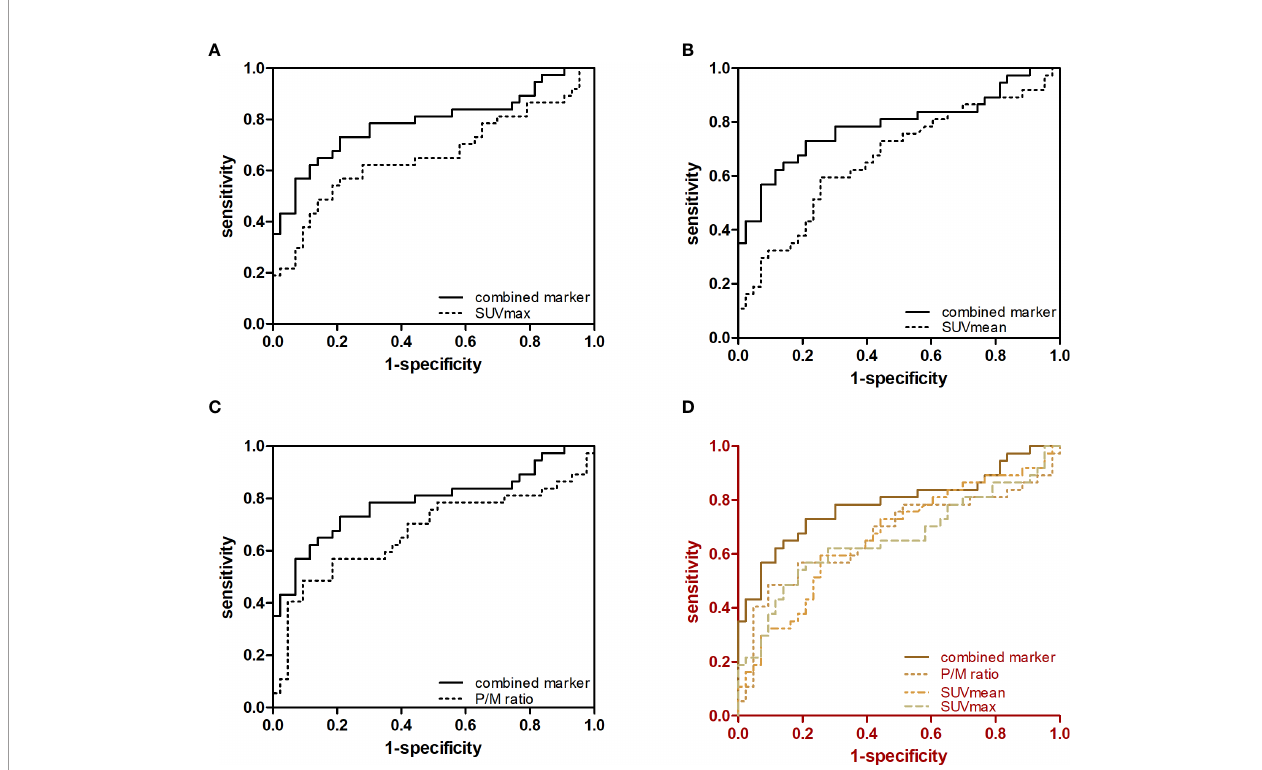
FIGURE 4 | Predictive value of single parameters and three-parameter combination in the diagnosis of early-stage PCa. ROC curves for (A) SUVmax and SUVmax + SUVmean + P/M ratio, (B) SUVmean and SUVmax + SVmean + P/M ratio, (C) P/M ratio and SUVmax + SUVmean + P/M ratio and (D) SUVmax, SUVmean, P/M ratio and SUVmax + SUVmean + P/M ratio in controls versus patients with early-stage PCa are